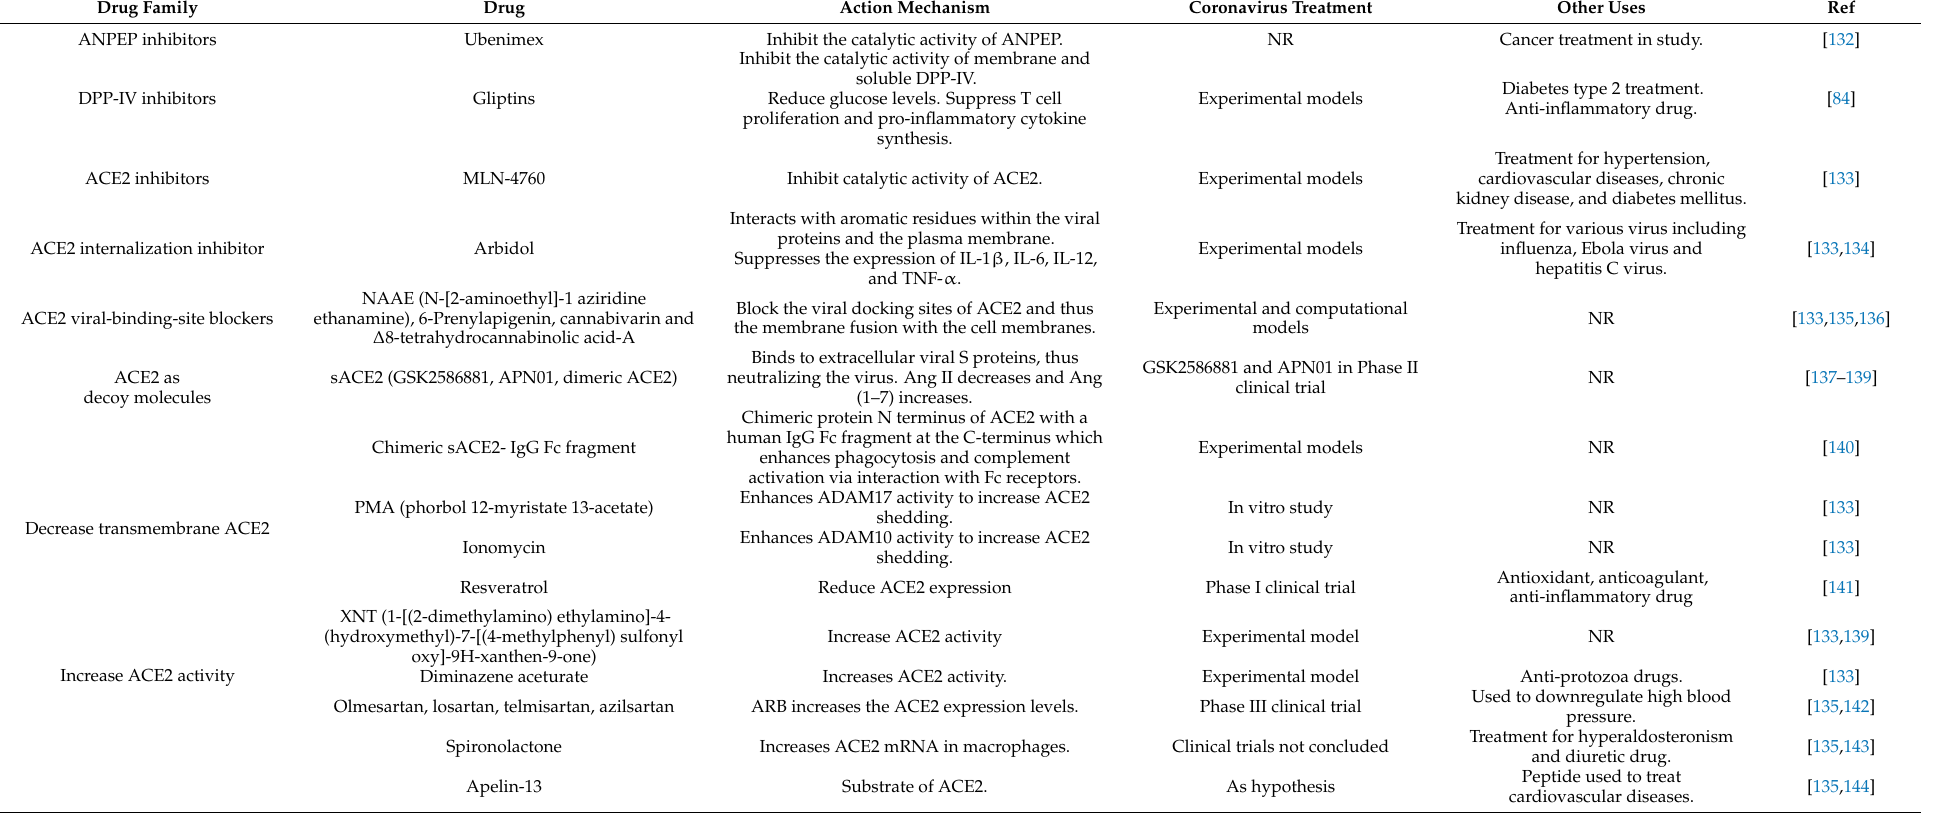
Table 2. Potential treatments for coronavirus infections that target the coronavirus